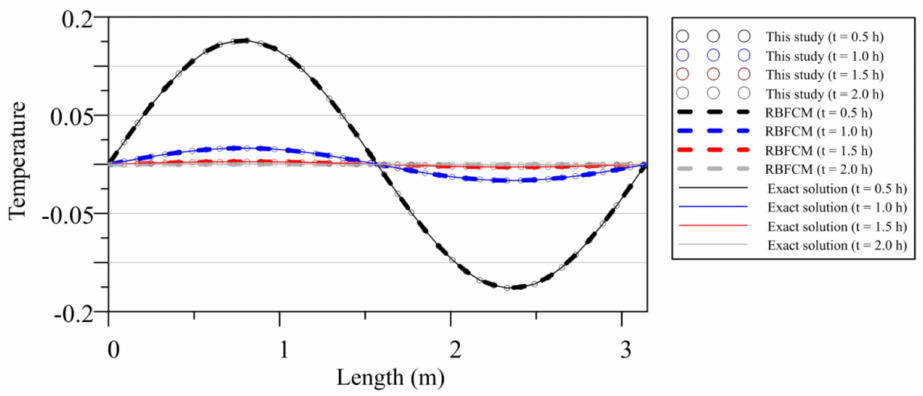
Figure 6. Comparison of the computed results with the exact solution.